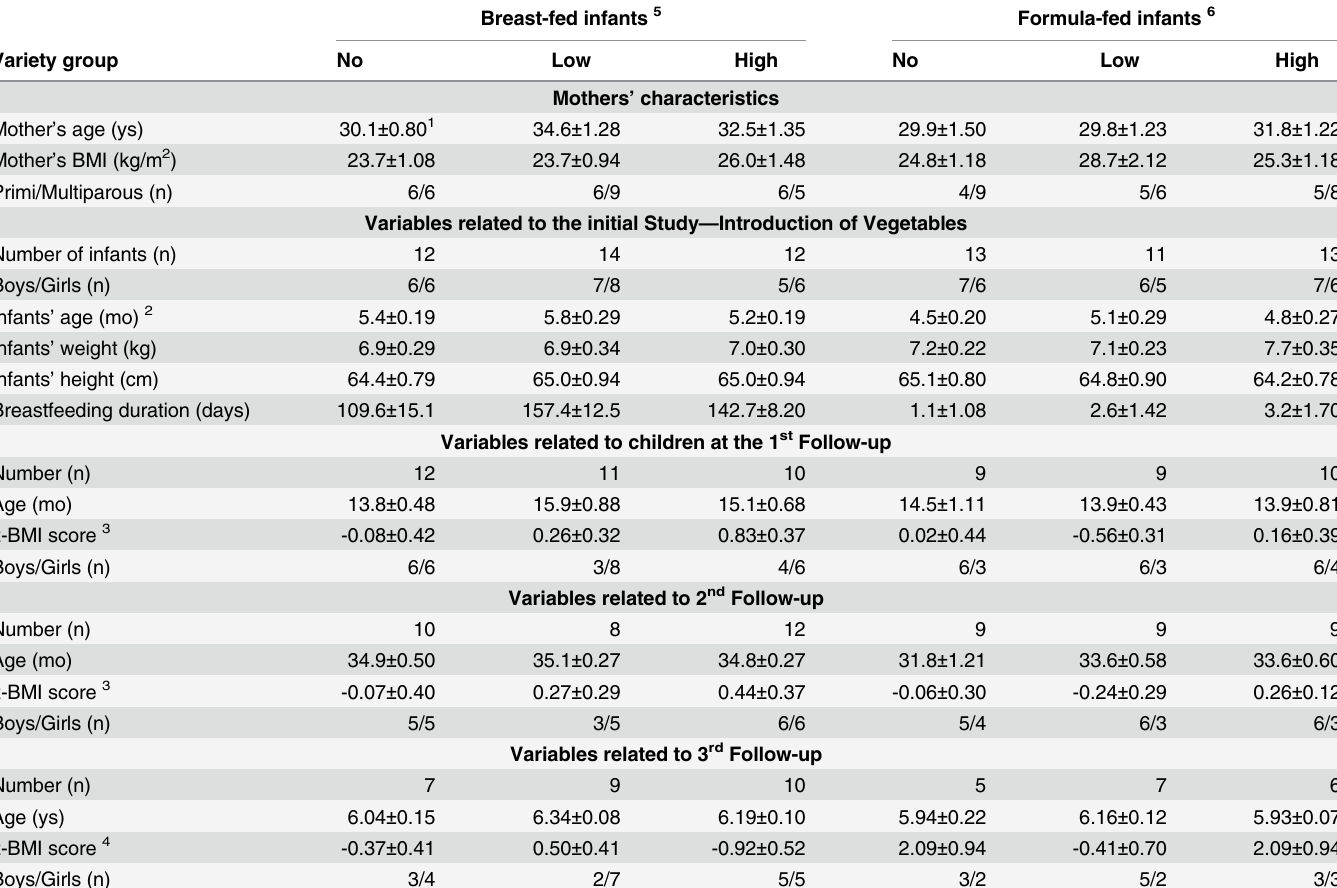
Table 2. Characteristics of the Aalen sample split by mode of milk feeding and variety exposure